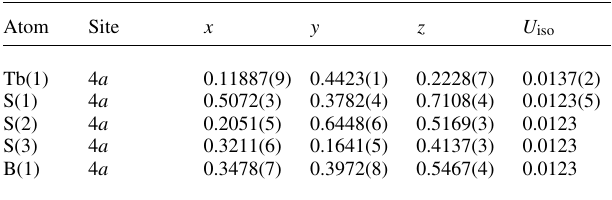
Table 1. Data collection and handling. Table 2. Atomic coordinates and displacement parameters (in Å 2 )